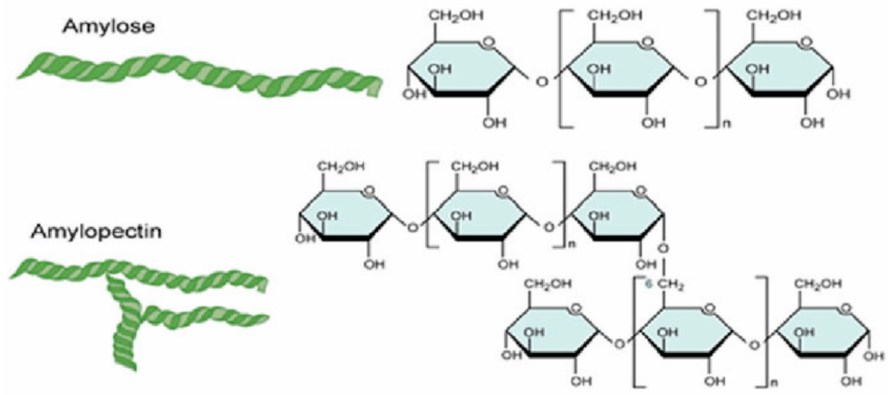
Figure 3. Structure of amylose and amylopectin that constitute starch molecule (retired from